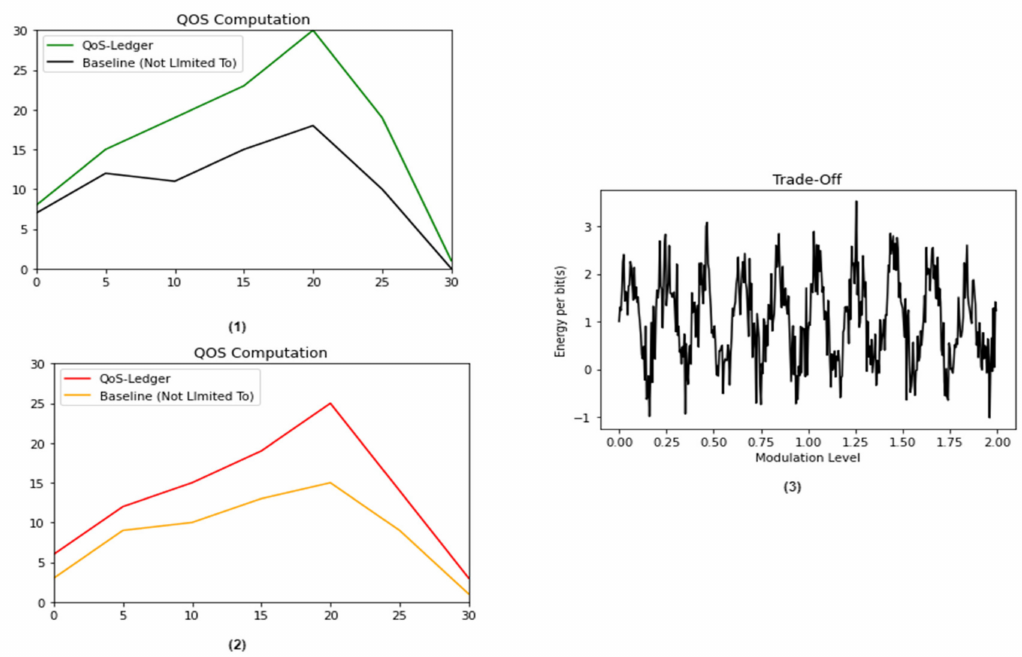
Figure 5. QoS computation and calculate the level of modulation: ( 1 ) Time-based QoS computation, ( 2 ) Data-rate-based QoS computation, and ( 3 ) Power-drain and modulation